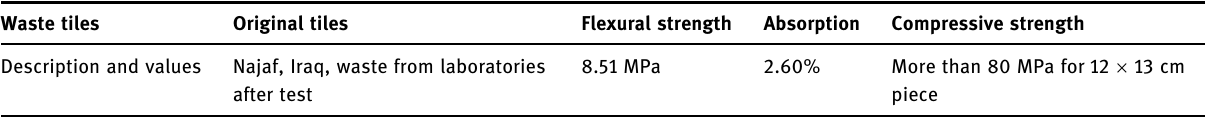
Table 5: Fine aggregate sieve analysis ( zone 3 grading )